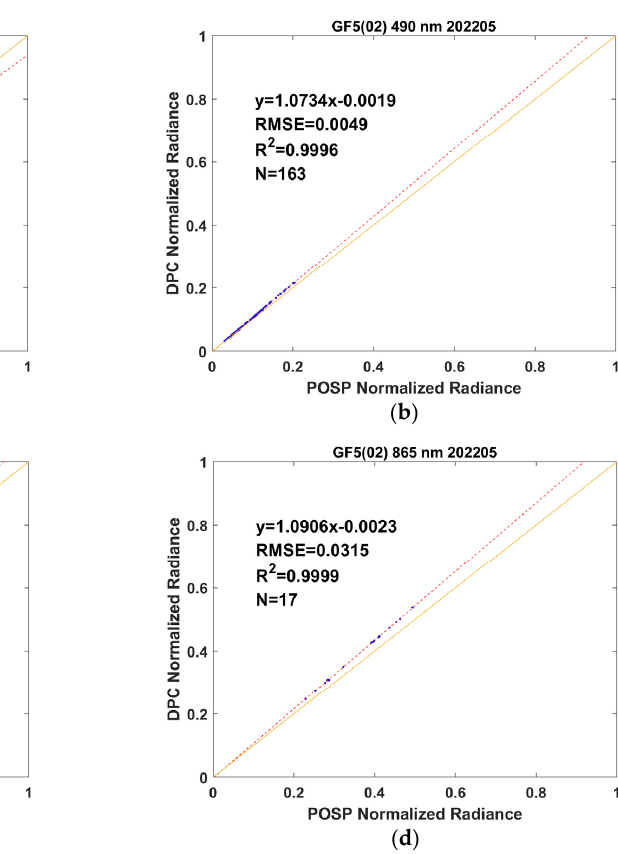
( c ) Figure 6. The time-varying characteristics of DPC and POSP normalized radiance linear fitting re- sults ( a ) 𝐴 (cid:3038) ; ( b ) R 2 ; and ( c ) RMSE in common spectral bands at nadir. These data pairs are selected from collections from November 2021 to May 2022 in DPC and POSP Level 1 products. DPC radiometric cross-calibration accuracy consists of three main error contributors: radiance measurement of POSP, transfer of this radiance to DPC, and DPC errors. The POSP onboard calibration error was preliminary evaluated at about 2.64–3.03% for all common bands. DPC errors include non-linearity, non-stability, out-of-band response, etc. that can be determined through laboratory testing, which was less than 1.1%. These two errors are only relevant to the sensors themselves and can be determined inde- pendently, not to the cross-calibration transfer process. While the sources of cross-calibra- tion uncertainty in the transfer process are mainly differences in spectral response, view- ing geometry, and target matching between the two sensors [40], as shown in Table 2. The bandwidth and center wavelength of DPC and POSP are almost the same (Figure 4), but different target types can introduce spectral response uncertainty of about 0.5% based on the spectral band adjustment factor (SBAF). DPC and POSP have strict constraints on viewing geometry consistency. The differences in viewing angles may introduce response uncertainty of about 0.2% based on the bidirectional reflectance distribution functions (BRDF) model of different target types. Additionally, the target matching uncertainty is related to the scene uniformity, which is about 0.1% for all selected data. Therefore, the combination of radiometric cross-calibration transfer uncertainty is on the order of 0.55%,